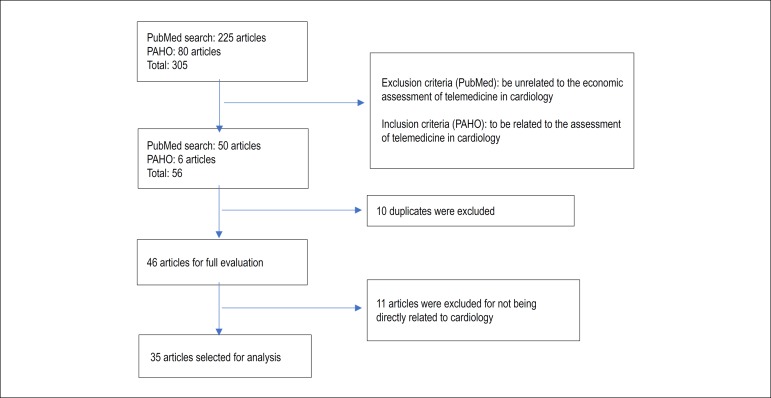
Flowchart of selection of articles on economic analysis of Telemedicine applied to cardiology.